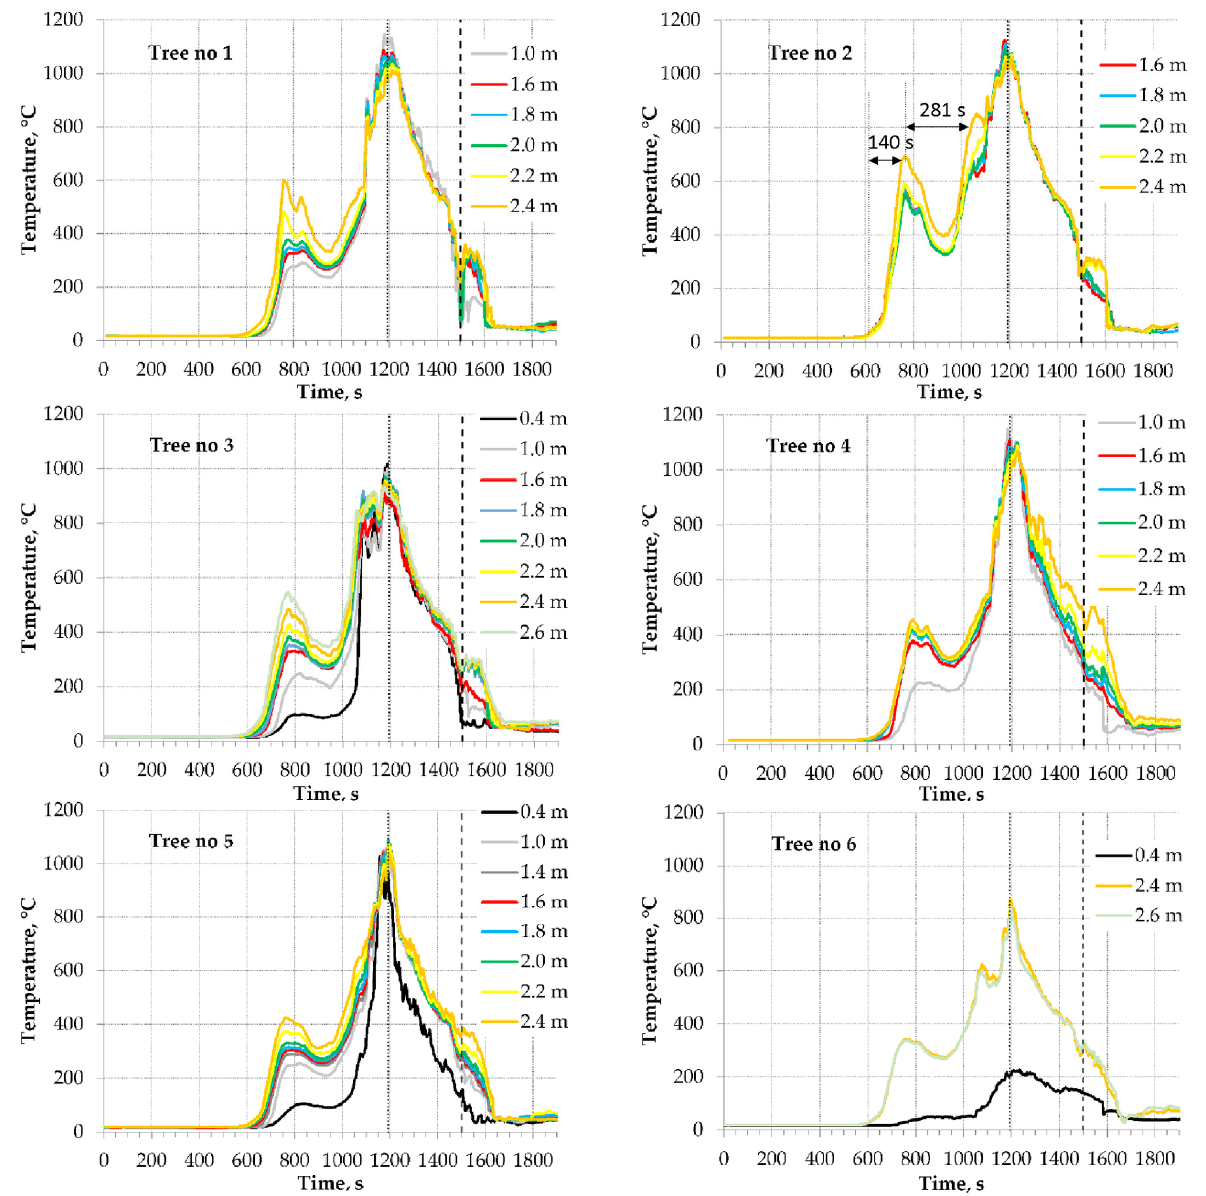
Figure 6. Temperatures during the second test. Dashed lines mark the beginning of the firefighting operations (1500 s), dotted lines mark the moment windows fell out (1193 s).